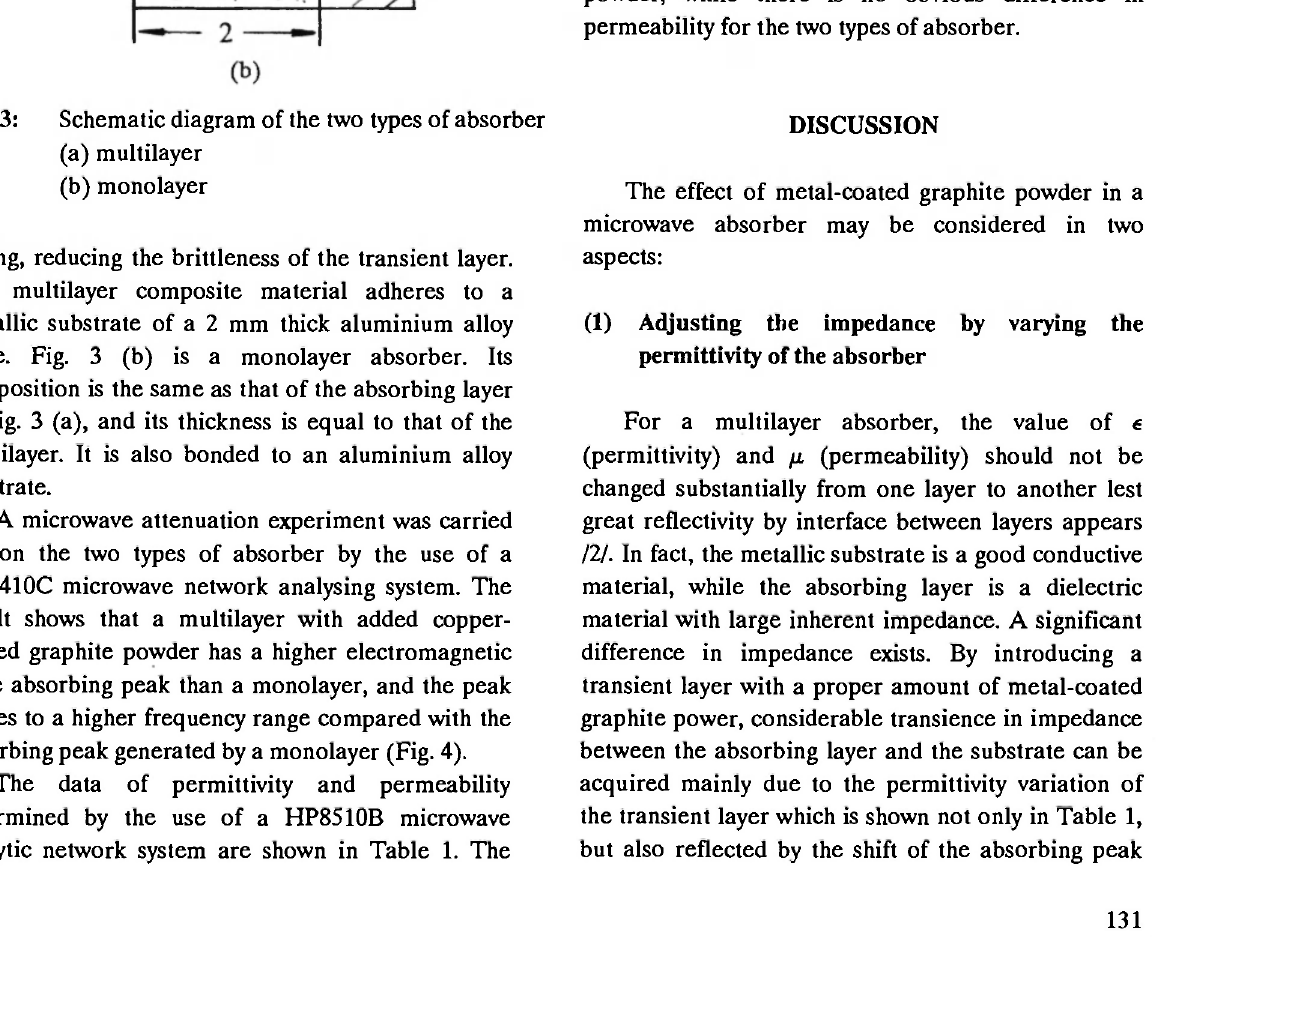
Fig. 4: Microwave attenuation comparison — multilayer structure — monolayer